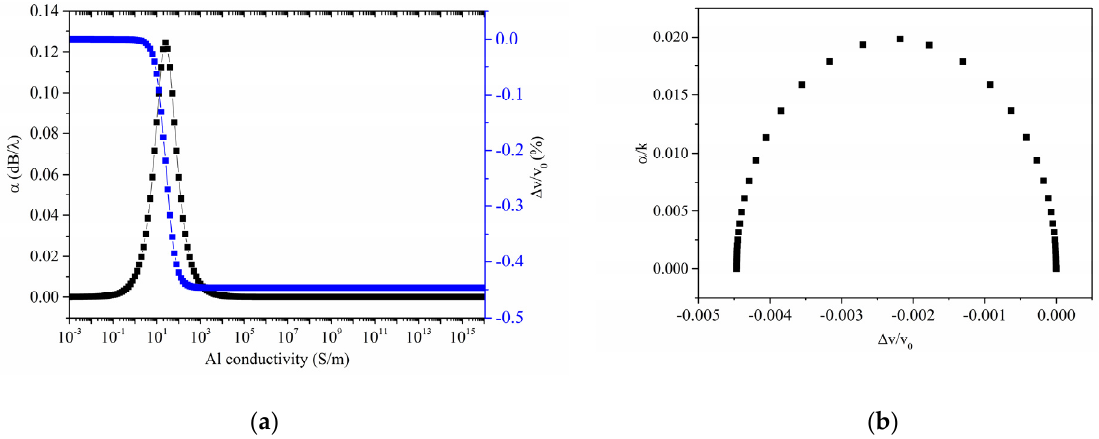
Figure 2. ( a ) The phase velocity and propagation loss vs. Al conductivity curves; ( b ) the parametric representation of the AE response, the α /k vs. ∆𝑣 𝑣 being k = 2 π / λ the wavevector.